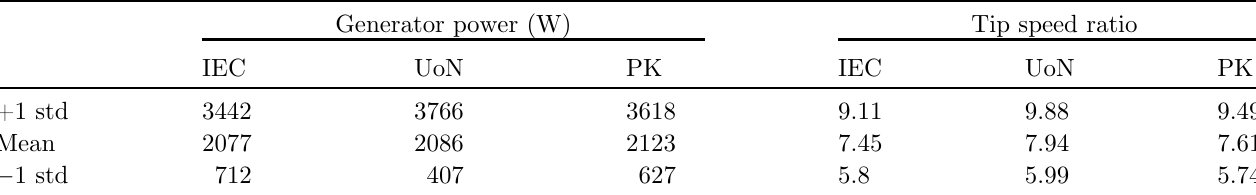
Table 1. Ten-min statistics for generator power and tip speed ratio.